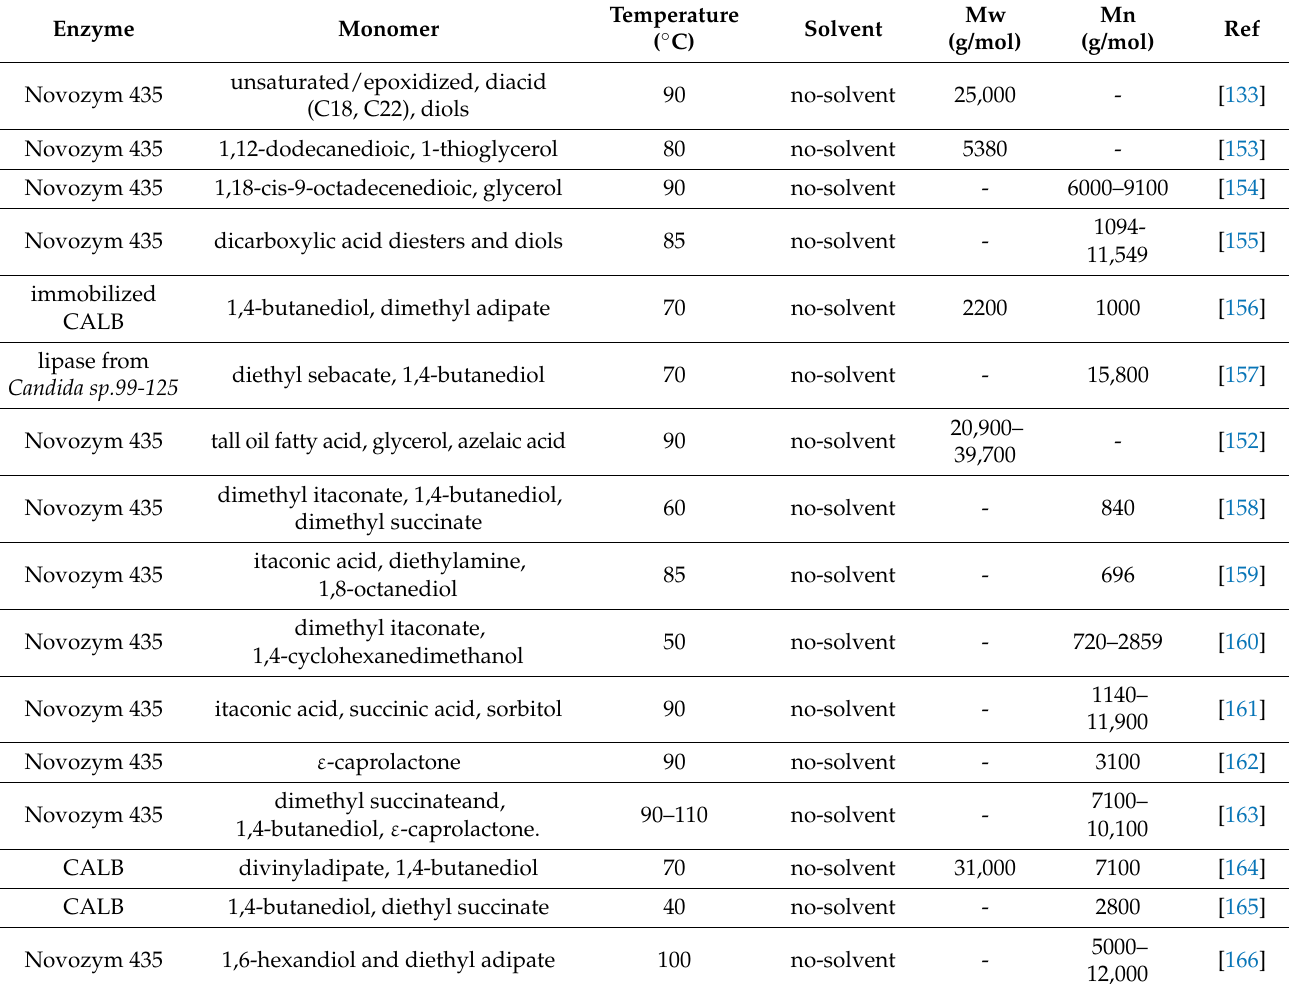
Table 3. Enzyme-catalyzed synthesis of polyesters in